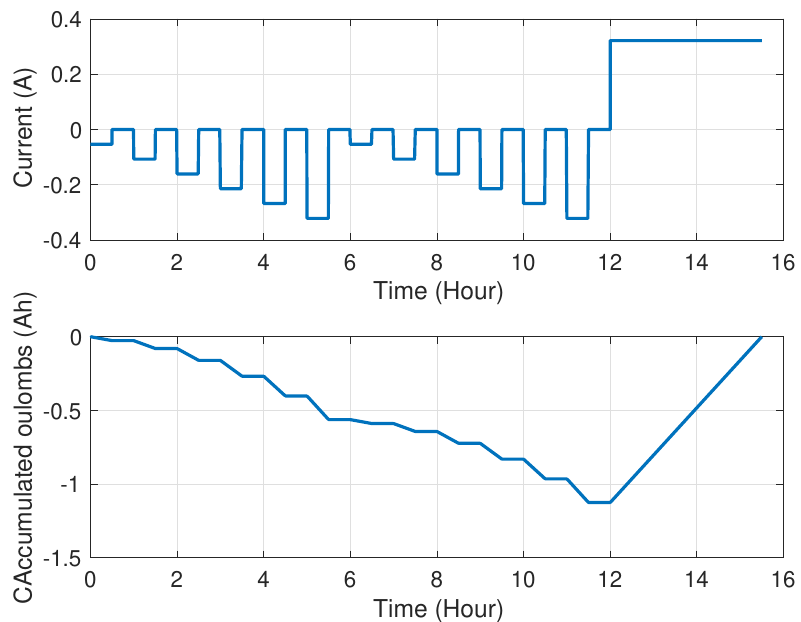
Figure 10. Simulated current profile and corresponding true SOC. This figure shows the difference between the true SOC and the SOC with battery capacity uncertainty after 100 runs of the Monte Carlo simulation.